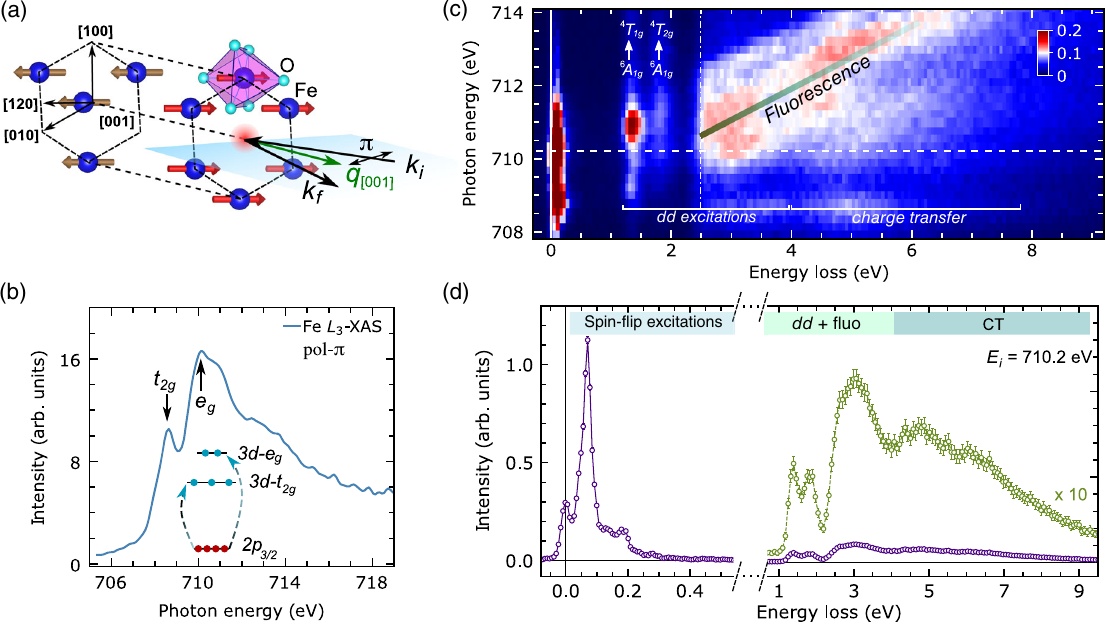
FIG. 1. Scattering geometry and experimental data for 30-nm α -Fe 2 O 3 film. (a) Crystal and magnetic structure of α -Fe 2 O 3 . The blue shaded area indicates the scattering plane defined by the [001] and [120] axes of the hexagonal unit cell. The black arrows labeled k ( k ) i f represent the incident (scattered) x rays, while the double arrow refers to the π polarization. The momentum transfer q (green arrow) is along the [001] direction. (b) Fe L 3 -edge XAS measured in the PFY mode using the RIXS spectrometer at Fe L 3 edge, θ ¼ 33 . 5 ° and 2 θ ¼ 67 °. The inset depicts the related Fe L 3 XAS process. XAS in total fluorescence or electron yield mode cannot be successfully measured in this sample due to technical difficulties. (c) RIXS energy dependence across the Fe L 3 edge at θ ¼ 20 ° and 2 θ ¼ 150 °, and π -polarized x rays. The horizontal dashed line indicates the incident photon energy 710.2 eV used for RIXS measurements, while the vertical dot-dashed line specifies the onset of fluorescence. (d) Overview of a typical high-resolution RIXS spectrum in purple color ( θ ¼ 45 °, 2 θ ¼ 90 °, and q ¼ 0 . 51 Å − 1 ). The high-energy-loss excitations are multiplied by a factor of 10 in the green colored spectrum to ease the visualization of the dd , charge transfer, and fluorescence fine structure. The error bars are defined assuming a Poisson distribution of the centroided, single-photon